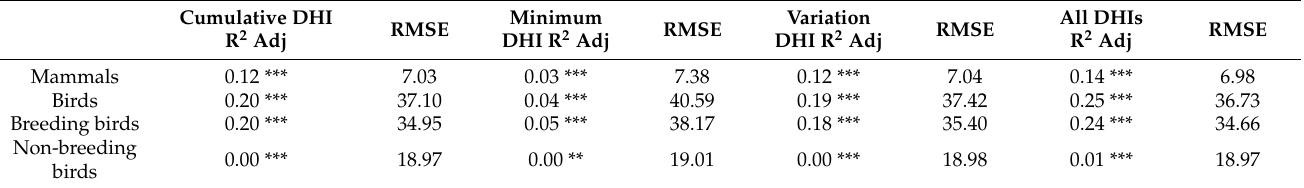
Table 3. Coefficient of determination between the individual FPAR-based DHIs of the four main taxa. Significant relations: ** p < 0.01; *** p <